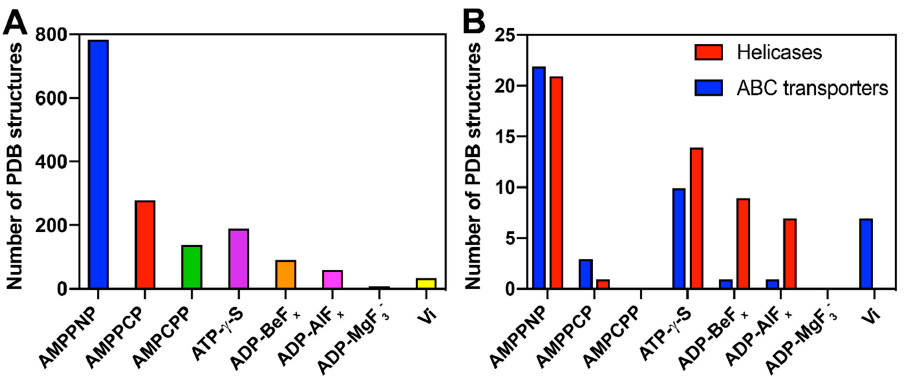
Figure 2. Distribution of the different NTP analogues based on the number of structures in the Protein Data Bank in December 2019. Number of Protein Data Bank structures for each analogue ( A ). Number of ABC transporters (blue, search query “ABC transporter + protein data bank accession codes of the ATP-analogue”) and helicases (red, search query “DNA helicase + PDB ID of the ATP-analogue”) Protein Data Bank structures for each analogue ( B ). Molecules 2020 , 25 , x